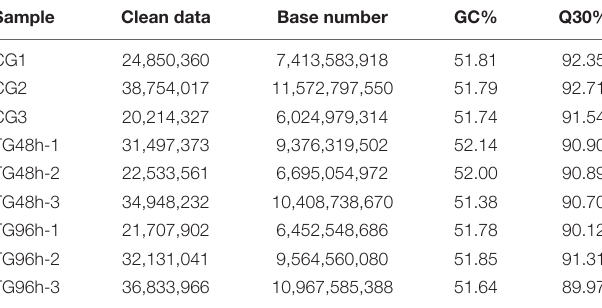
TABLE 3 | Quality of sequencing.